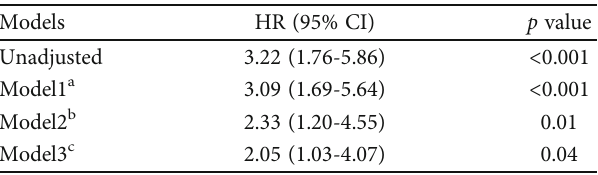
Table 2: Cox regression analysis of the e ff ect of serum chloride ion on the prognosis of IgAN patients.